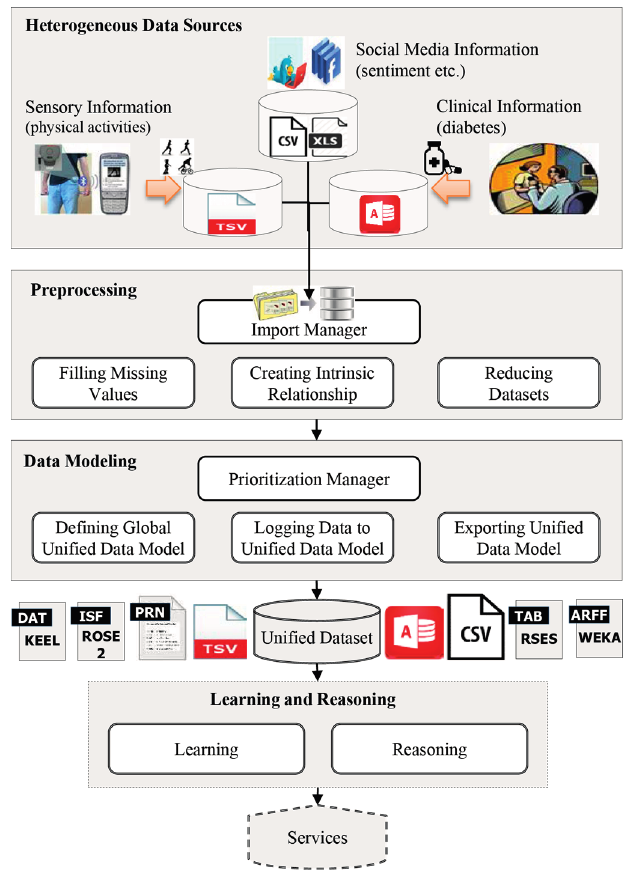
Figure 3. Architecture of the “data modeler” based on global unified data